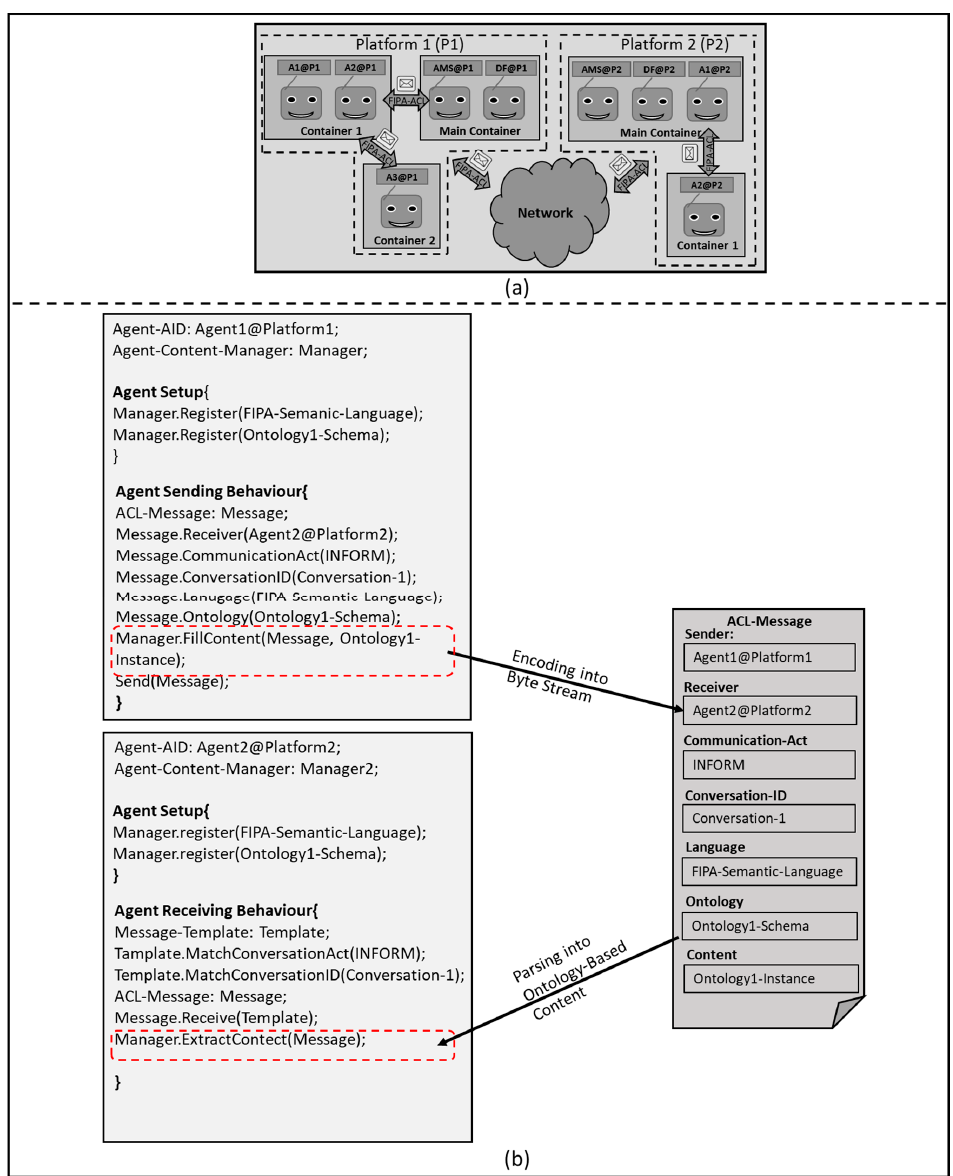
Figure 3. ( a ) Java Agent Development (JADE); ( b ) Ontology-Based Agent Communication Language (ACL)-Message Exchange.